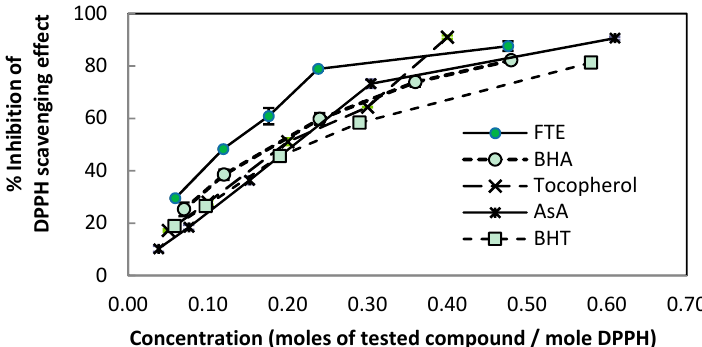
Figure 2. The percent inhibition of DPPH radical-scavenging activity. Data are expressed as the mean ± standard deviation (SD) ( n = 2). The values are significantly different at p < 0.05. The reduction of the DPPH radical was measured by the decrease of absorbance at 515 nm as a function of the concentration of the FTE and the reference standards.